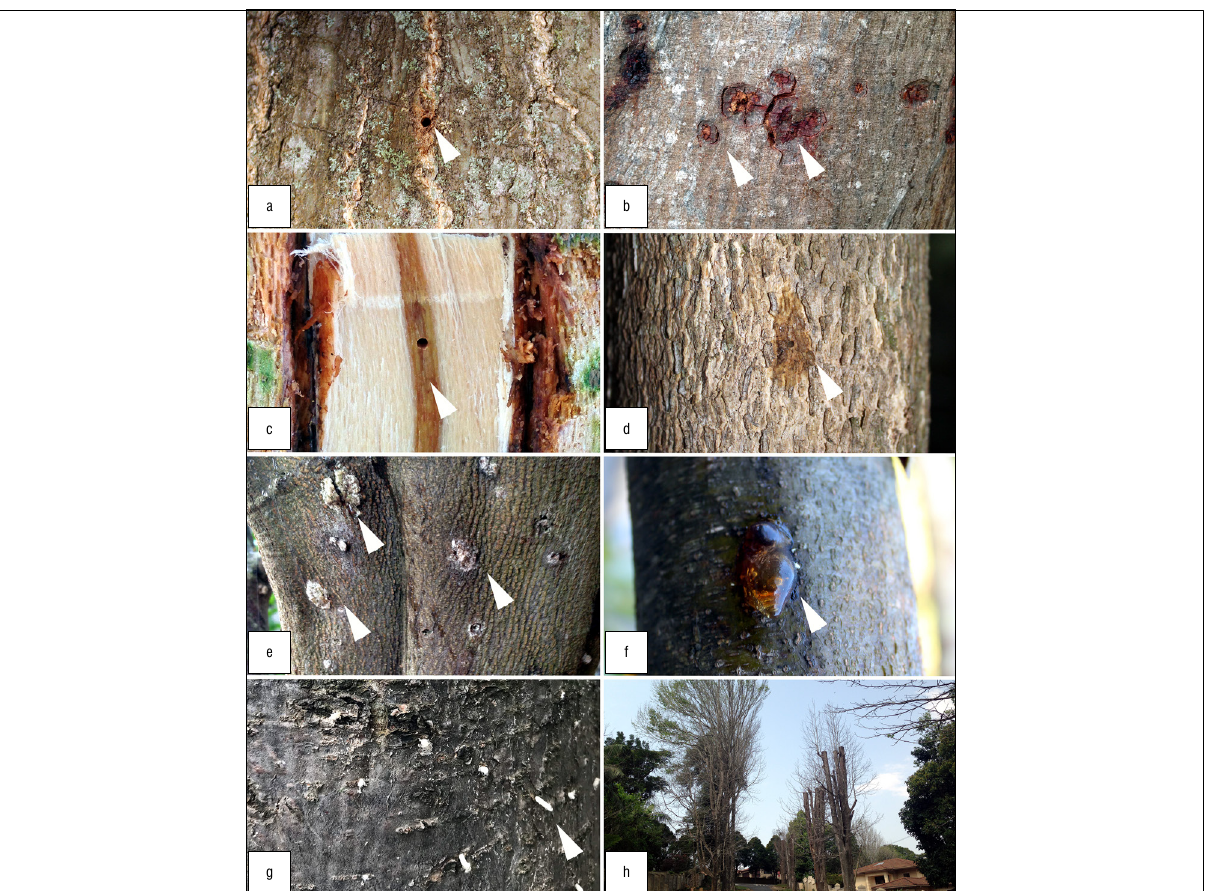
Figure 3: Signs of infestations of polyphagous shot hole borer (PSHB) beetle, Euwallacea fornicatus, on various hosts: (a) ca. 0.85-mm diameter entrance hole of PSHB on the bark of Erythrina caffra . (b) Lesions on the bark of Acacia mearnsii around entrance holes of PSHB. (c) Colonisation of vascular tissues by Fusarium euwallaceae (staining) surrounding the entrance hole of PSHB under the bark of Platanus x acerifolia . (d) Wet patch on the bark of Nuxia floribunda following infestation by PSHB. (e) Sugar fountain (dried sugary sap) on the bark of Grewia occidentalis following infestation by PSHB. (f) Gum exudates (tree resin flow) on the bark of Podalyria calyptrata following infestation by PSHB. (g) Noodles (compacted frass) extruded from the galleries of PSHB following infestation of Harpephyllum caffrum . (h) Liquidambar styraciflua individuals showing dieback of branches and tree death following heavy infestations by